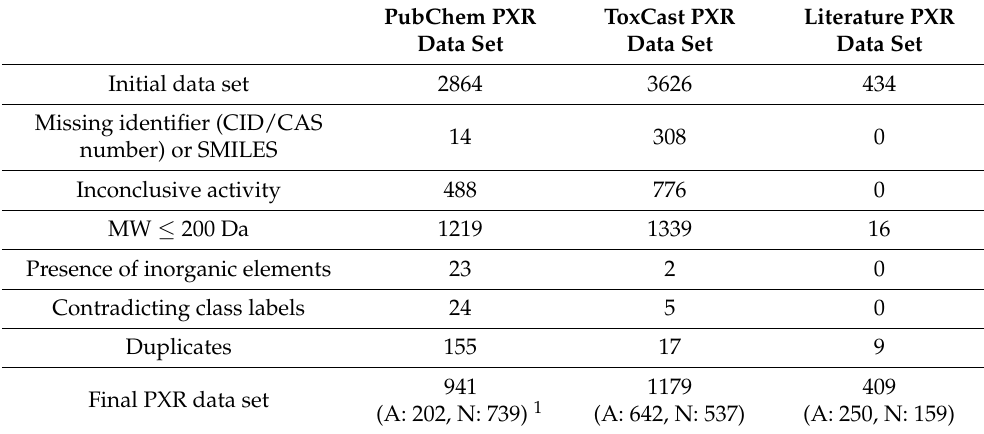
Table 1. Filter criteria and number of compounds removed during each step of the data